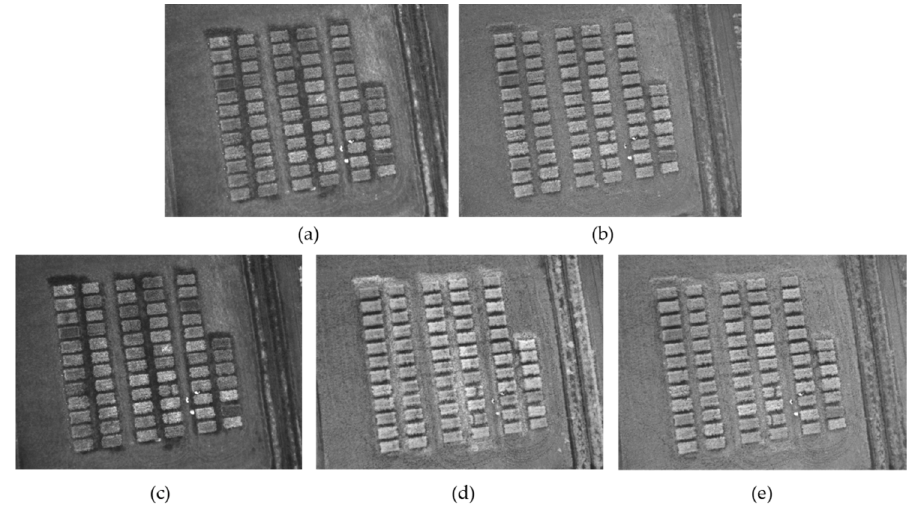
Figure 4. Image Set III: images from field plots in a trial evaluating disease resistance in rice cultivars at the Texas A&M AgriLife Research and Extension Center, Beaumont, Texas, USA were taken as follows: ( a ) blue band image; ( b ) green band image; ( c ) red band image; ( d ) NIR band image; and ( e ) red-edge band image.